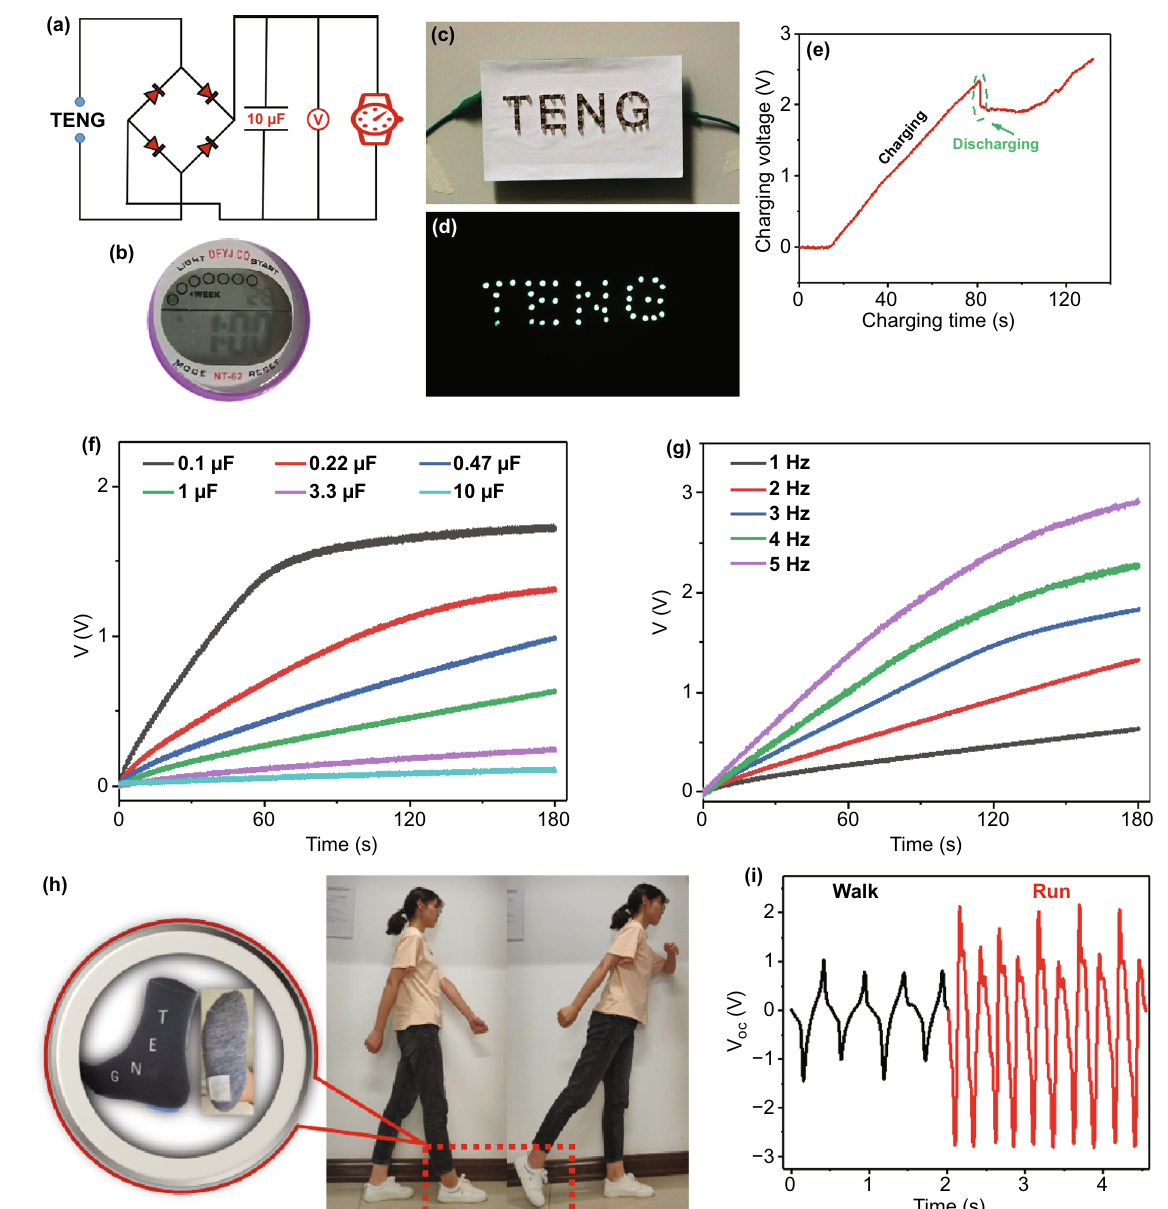
Fig. 4 Energy-harvesting capability of the F-TENG. a Circuit diagram of the charging system for the F-TENG. b Photograph showing that a commercial watch is on the working state. c , d Demonstration of lighting up different LED units by tapping a single F-TENG. e Charging volt- age of the F-TENG as a function of charging time. f , g Charging capability of the F-TENG under different capacitance capacities (1–10 µF) ( f ) and under different striking frequencies (1–5 Hz) ( g ). h–i A pedometer system fabricated by attaching the F-TENG on a sock. h Schematic dia- gram and i voltage signal output under the walking and running